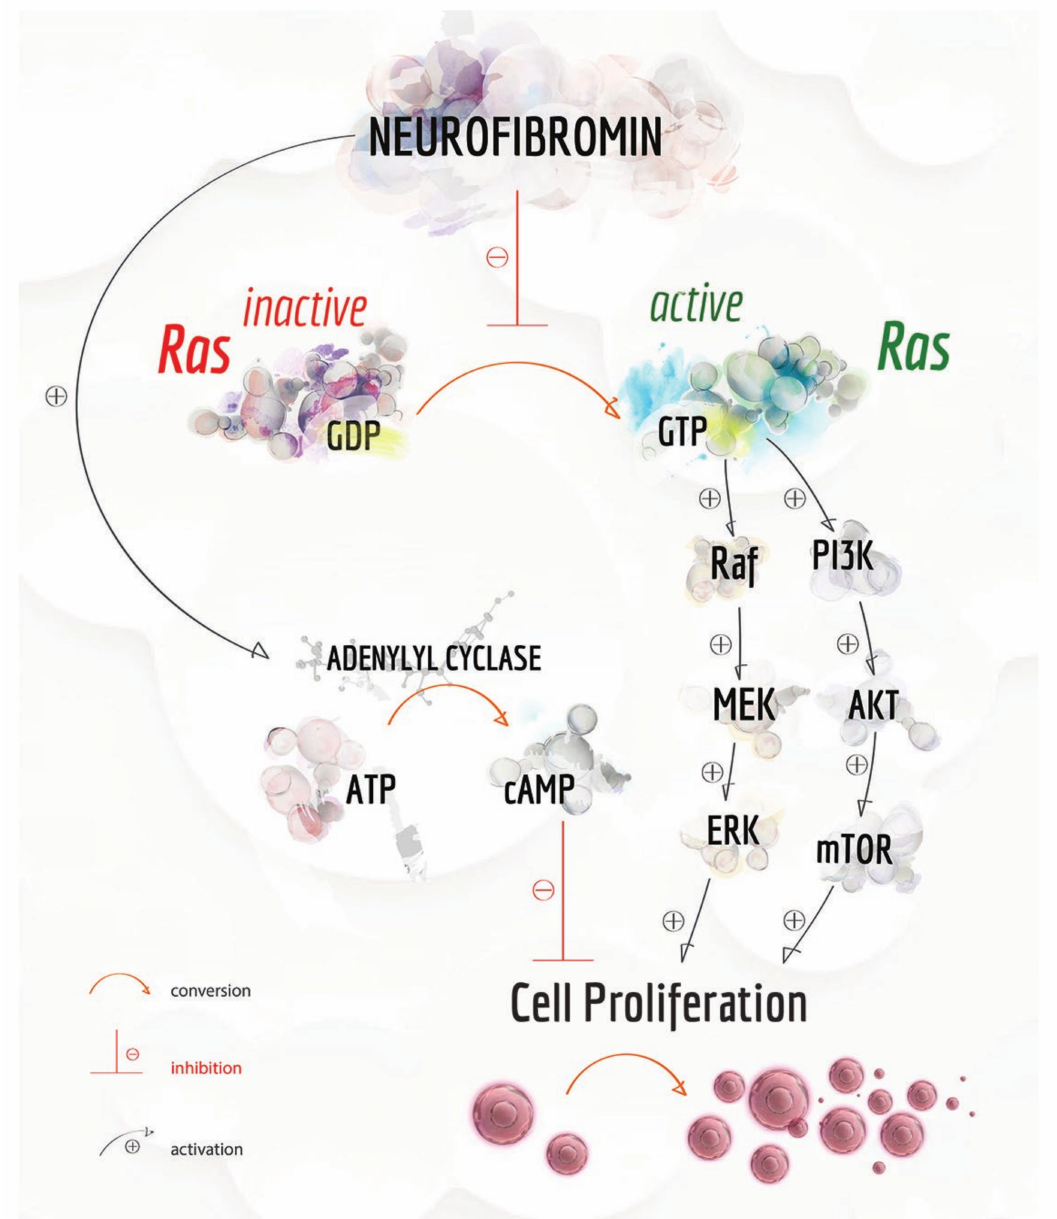
Figure 3. Schematic representation of the neurofibromin signalling pathways. Neurofibromin positively regulates adenylyl cyclase which, converting ATP in cAMP, increases the intracellular cAMP levels with consequent inhibition of cell proliferation. In addition, neurofibromin promotes the conversion of active GTP-bound Ras to its inactive GDP-bound conformation. The downstream e ff ectors of the Ras pathway include mitogen-activated protein kinase (MAPK) and the phosphatidylinositol-3-phosphate kinase (PI3K). The activation of these Ras-triggered pathways leads to cell proliferation and tumour growth. Therefore, neurofibromin—acting as a negative modulator of the Ras signalling—exerts a tumour suppressor activity. Figure was redrawn from Lobbous et al.